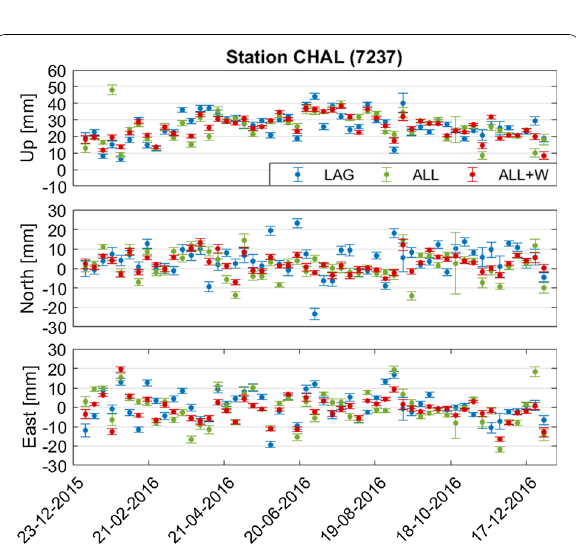
Fig. 13 Time series (with error bars) of station coordinate residuals for Changchun (7237) station for LAG, ALL, and ALL w.r.t. SLRF2014. Notice the change of residual range for Up component (top